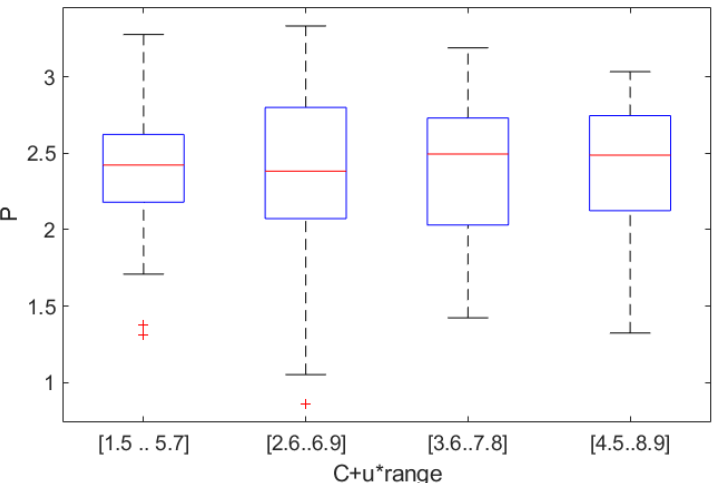
Figure 8. Power consumption range in a time interval of 200 s with a dependency on the thermal capacitance of 40